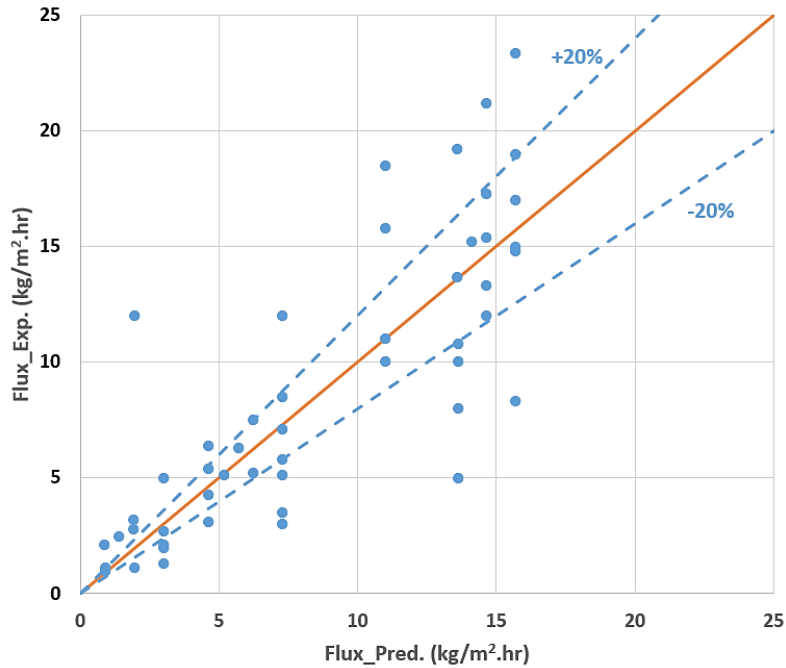
Figure 9. Predicted versus experimental values of permeat flux.